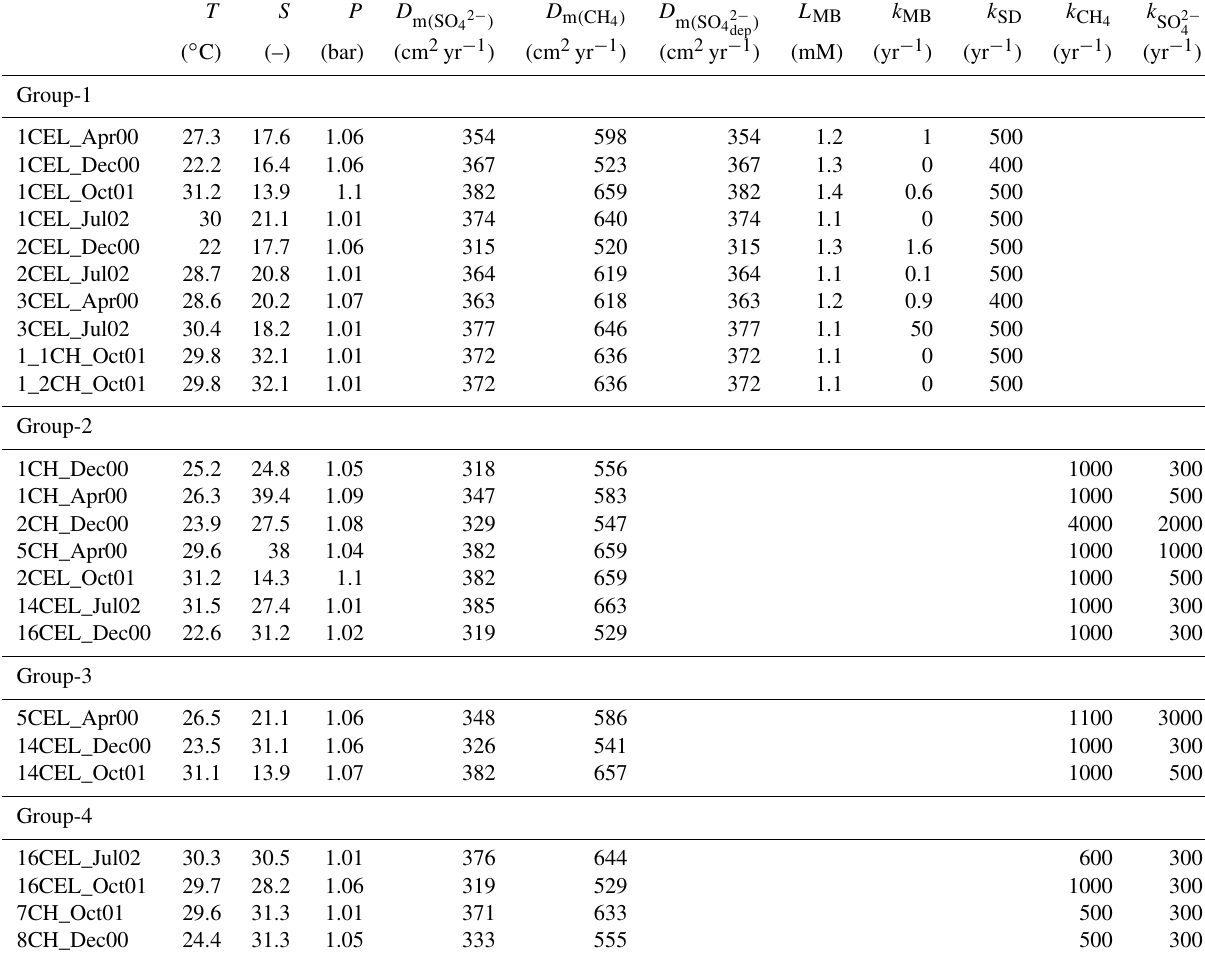
Table A3. Imposed and best-fit model parameters in each